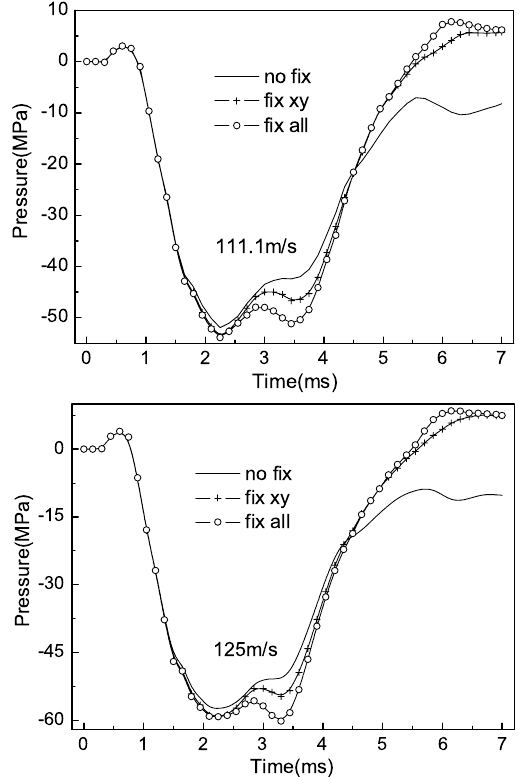
Fig. 16. Time history of pressure at the center on inner surface for different boundary conditions.